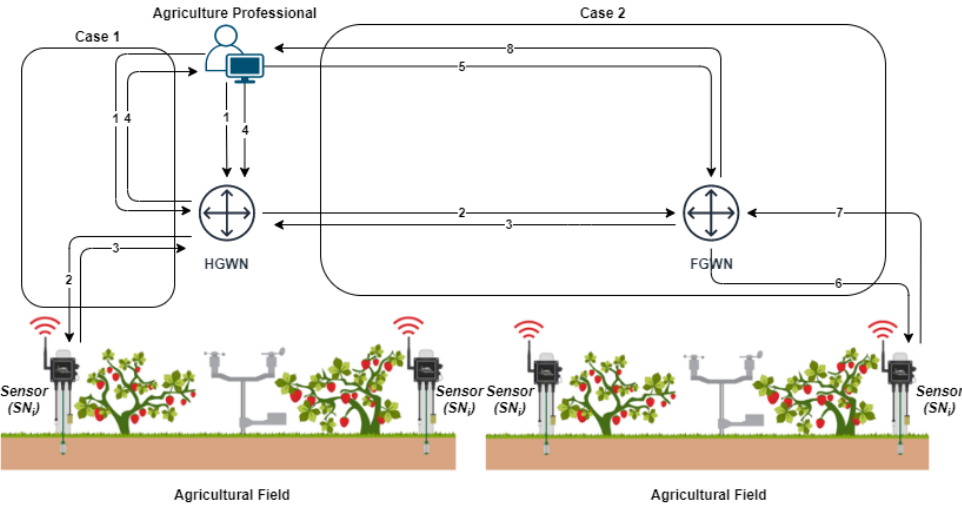
Figure 5. The proposed scheme communication models. Table 2.